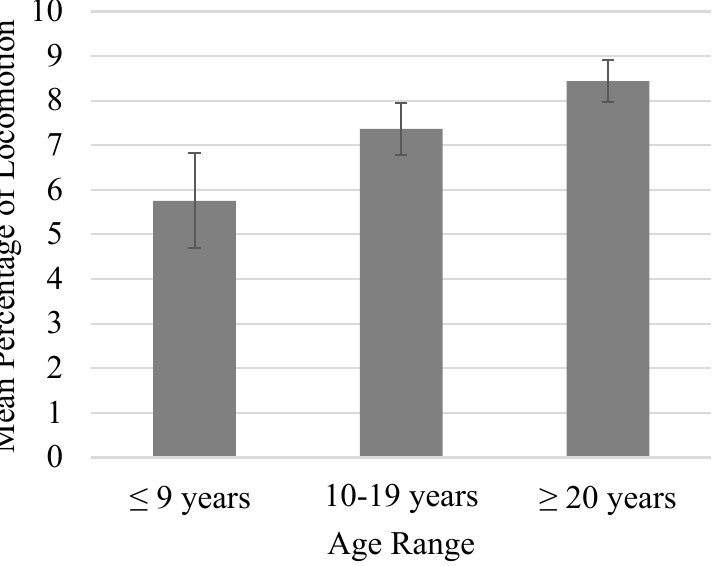
Figure 2. Mean percentage of time spent locomoting as a function of within-group age range. Error bars represent the standard error of the mean. Locomotion was trending higher in groups with a larger within-group age range ( p = 0.067).